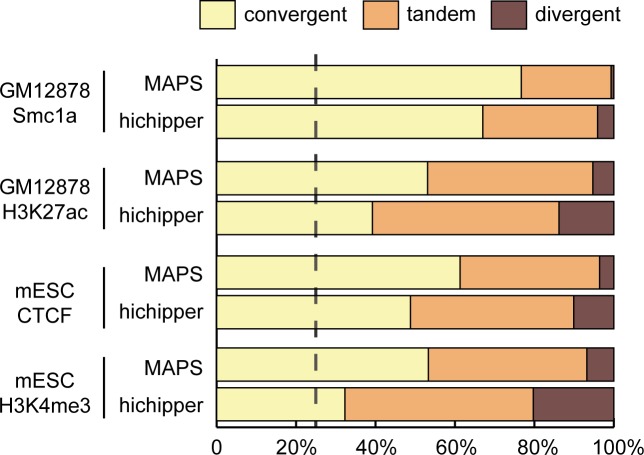
CTCF motif orientation of MAPS- and hichipper-identified interactions.The proportion of convergent, tandem and divergent CTCF motif pairs among testable MAPS- and hichipper-identified interactions. Only interactions with both ends containing either single CTCF motif or multiple CTCF motifs in the same direction are considered. The dotted vertical line indicates the expected convergent proportion from randomly chosen CTCF motif pairs (25%).